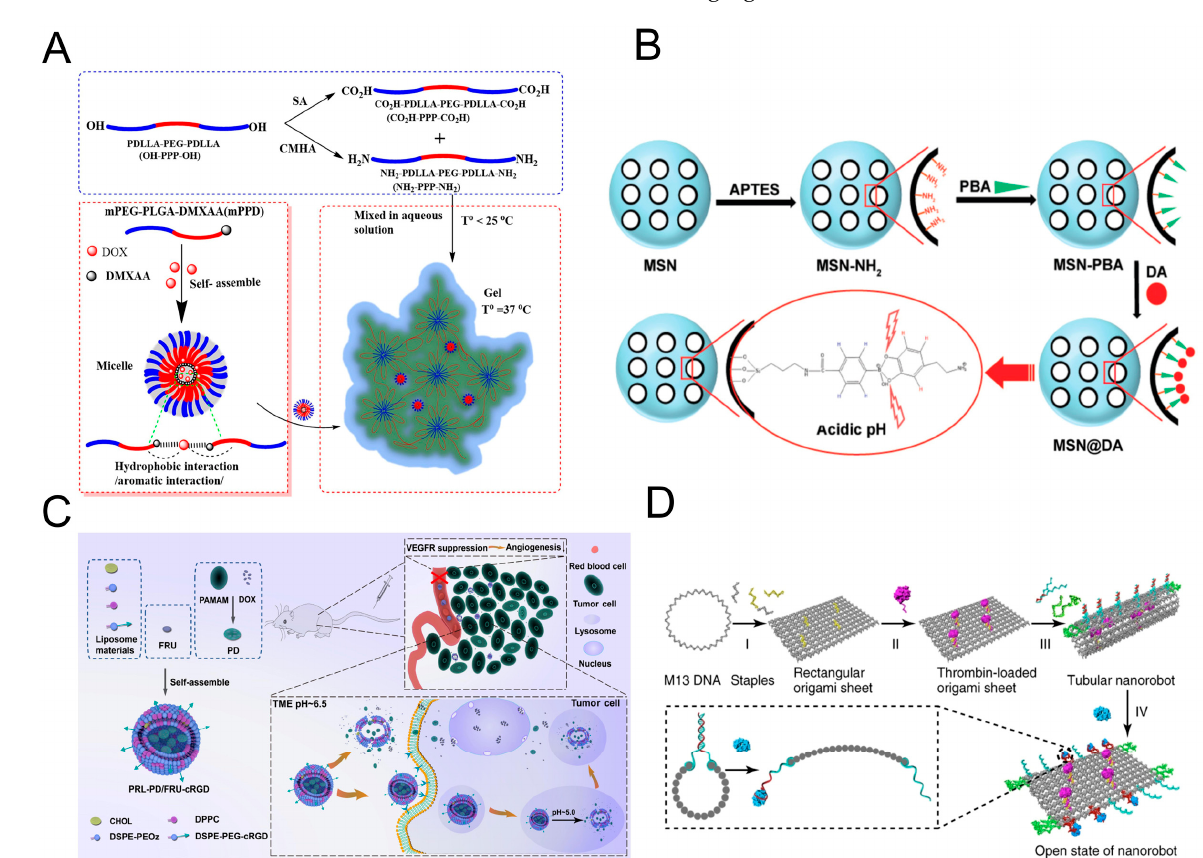
Figure 1. Antivascular therapy combined with nanoparticles to enhance chemotherapeutic drug delivery. ( A ) Schematic representation of hydrogel-based dual drug delivery for local treatment.